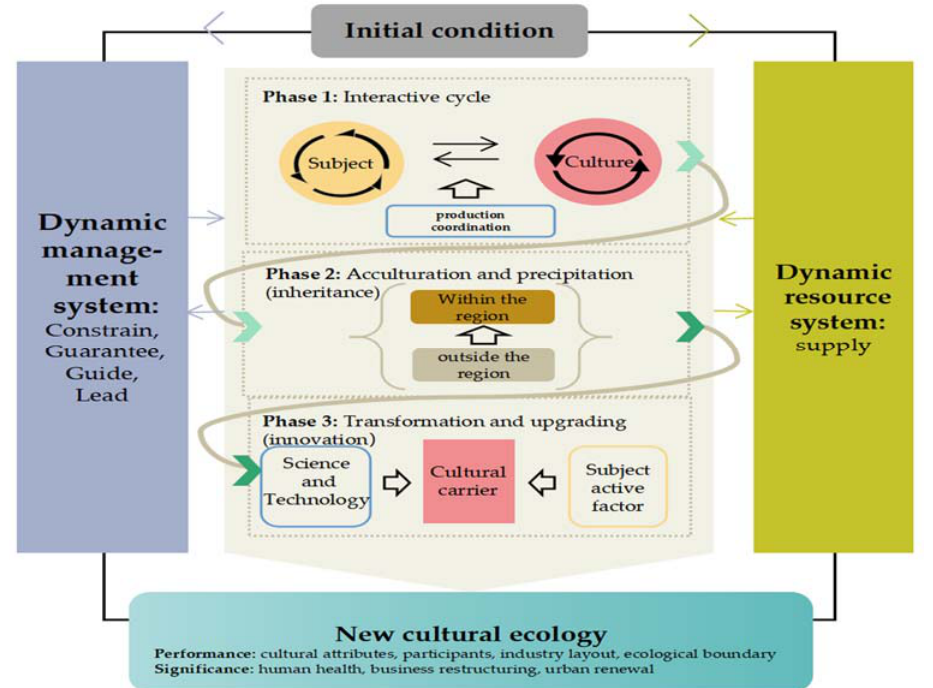
Figure 7. Cultural ecological evolution model of Shiwan pottery sculpture technique.